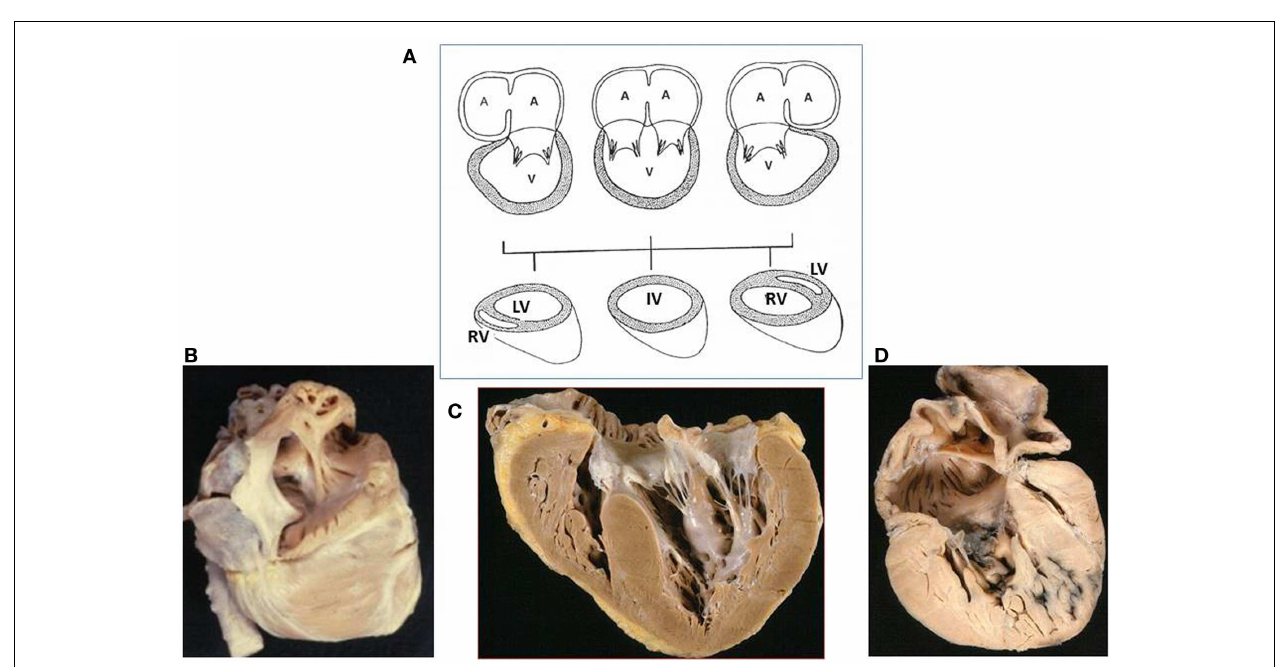
atrioventricular connection (tricuspid atresia), viewed from the right atrium: no orifice is present at the right atrial floor. (C) Double inlet ventricle: two separate valves drain into a main ventricular chamber of left morphology: note the hypoplastic right ventricle.The right atrioventricular valve is overriding the interventricular septum. (D) Absent left atrioventricular connection (mitral atresia): no orifice is present at the left atrial floor and the left ventricle is slit-like. A, atrium; IV, indeterminate ventricle; LV, left ventricle; RV, right ventricle;V, ventricle. [partially modified from Ref.